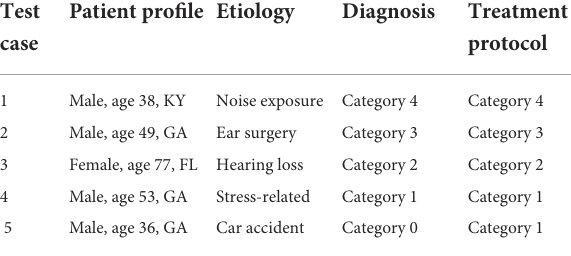
TABLE 7 Patient test cases—patient profile, etiology of their hearing problem, the diagnosed category, and the treatment protocol determined by the